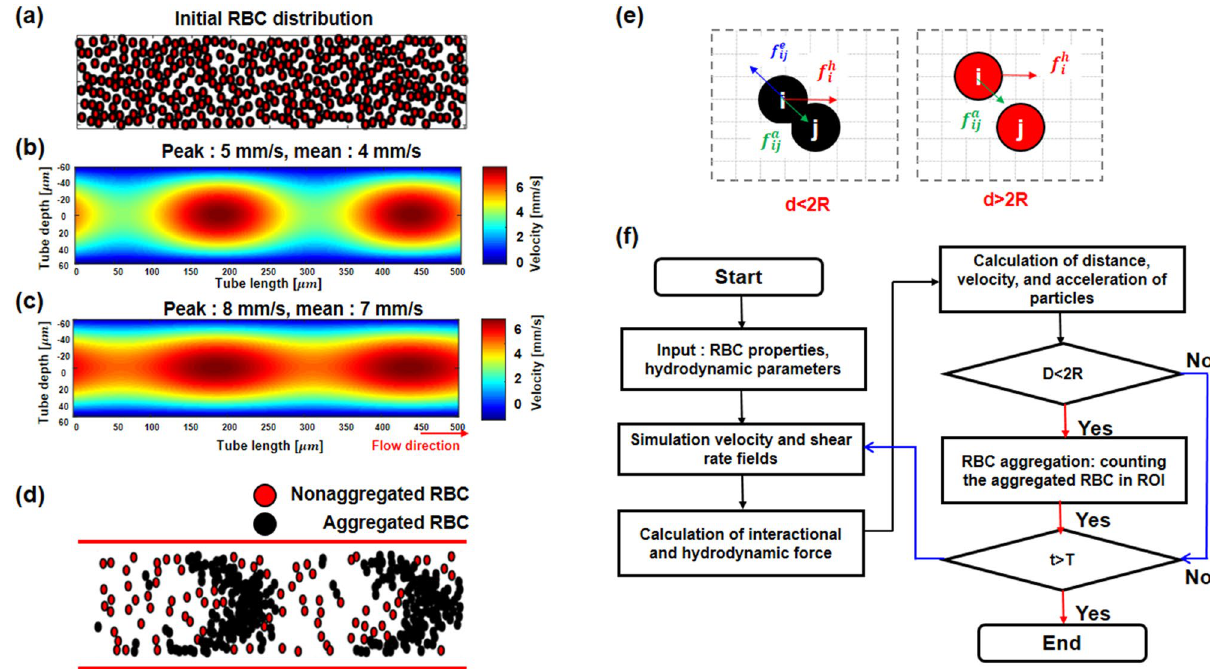
Figure 8. Dynamic RBC modeling and flow chart for analyzing the mechanisms of RBC aggregation under sinusoidal pulsatile flow. ( a ) In the initial step, the particles of 533 RBCs (hematocrits: 40%) were randomly positioned without aggregated RBCs in a 2D rigid tube. ( b ) The flow field represents sinusoidal pulsatile flow with a mean flow velocity of 4 mm/s and a velocity amplitude of 1 mm/s. ( c ) Flow field with a mean flow velocity of 7 mm/s with the same amplitude of velocity. ( d ) Schematic of the RBC distribution in a tube. Red and black particles indicate nonaggregated and aggregated RBCs, respectively. ( e ) Based on the depletion model, the elastic force ( f e ij ), aggregational force ( f a ij ), and hydrodynamic force ( f h i ) determine the distance ( d ), velocity, and acceleration of two particles. R is the radius (4 μm) of an RBC. The RBC motion and forces between the particles are calculated during a pulsatile cycle with the designed flow characteristics. ( f ) Flow chart of numerical RBC modeling. In a specific ROI, RBC aggregation was analyzed considering the spatial and temporal variation in radial and axial shear rates under pulsatile flow. t is time, and T is a period of sinusoidal pulsatile flow. The RBC modeling was implemented using MATLAB (The Math Works, Inc. MATLAB . Version 2020a, The Math Works, Inc., 2020. Computer Software. www. mathw orks.